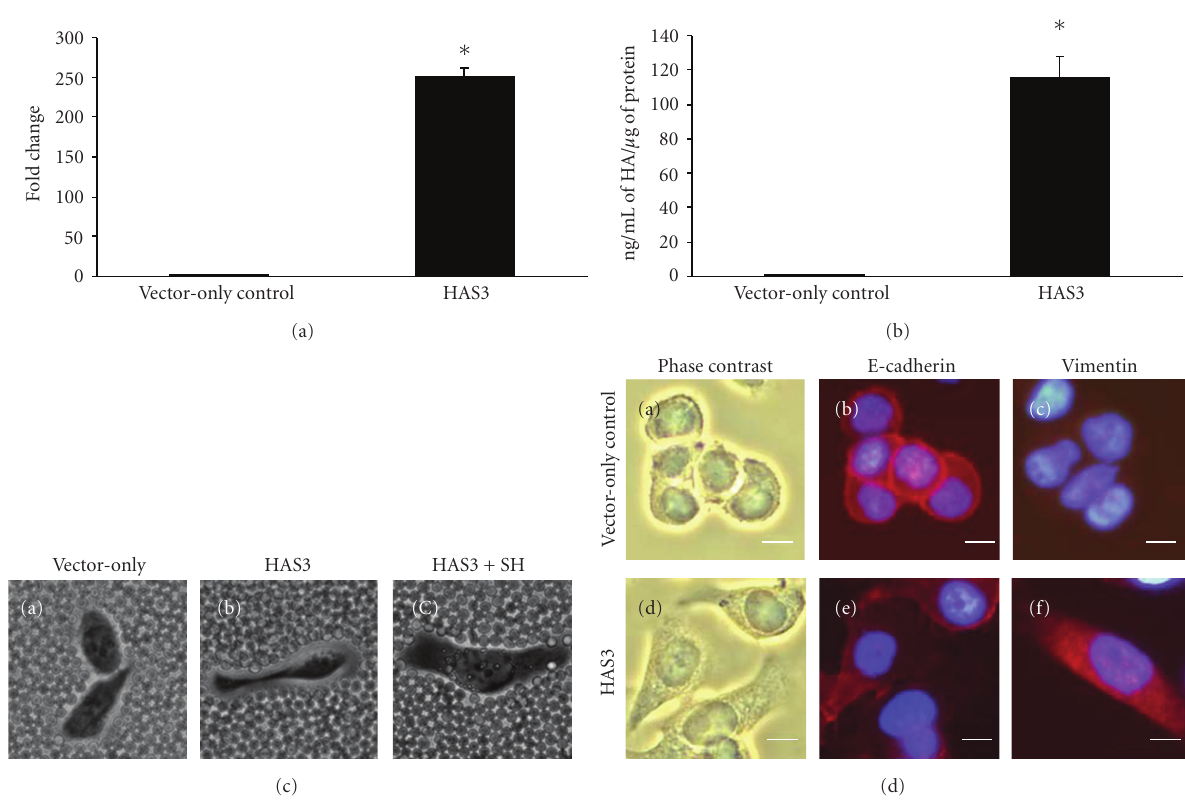
Figure 3: Enhanced HA production promotes mesenchymal-like phenotype in H358 cells. H358 cells were stably transfected with either vector only acting as a control or HAS3 gene. Stable transfectants were assessed for (a) HAS3 mRNA expression by quantitative real time RT-PCR; (b) total HA production; (c) HA-dependent matrix visualized by particle exclusion assay; (d) expression of E-cadherin ( (b) and (e) ) and vimentin ( (c) and (f) ) by immunocytochemistry using the antibody against E-cadherin and vimentin and counterstained using 4 (cid:3) ,6-diamidino-2-phenylindole. Cells in (a) and (d) were taken using a phase-contrast microscope. Scale bar: 10 μ m. Three experiments analyzed in triplicate were carried out for (a) and (b). The data shown is a representative. (Values are mean ± SD, n = 3, ∗ P < .